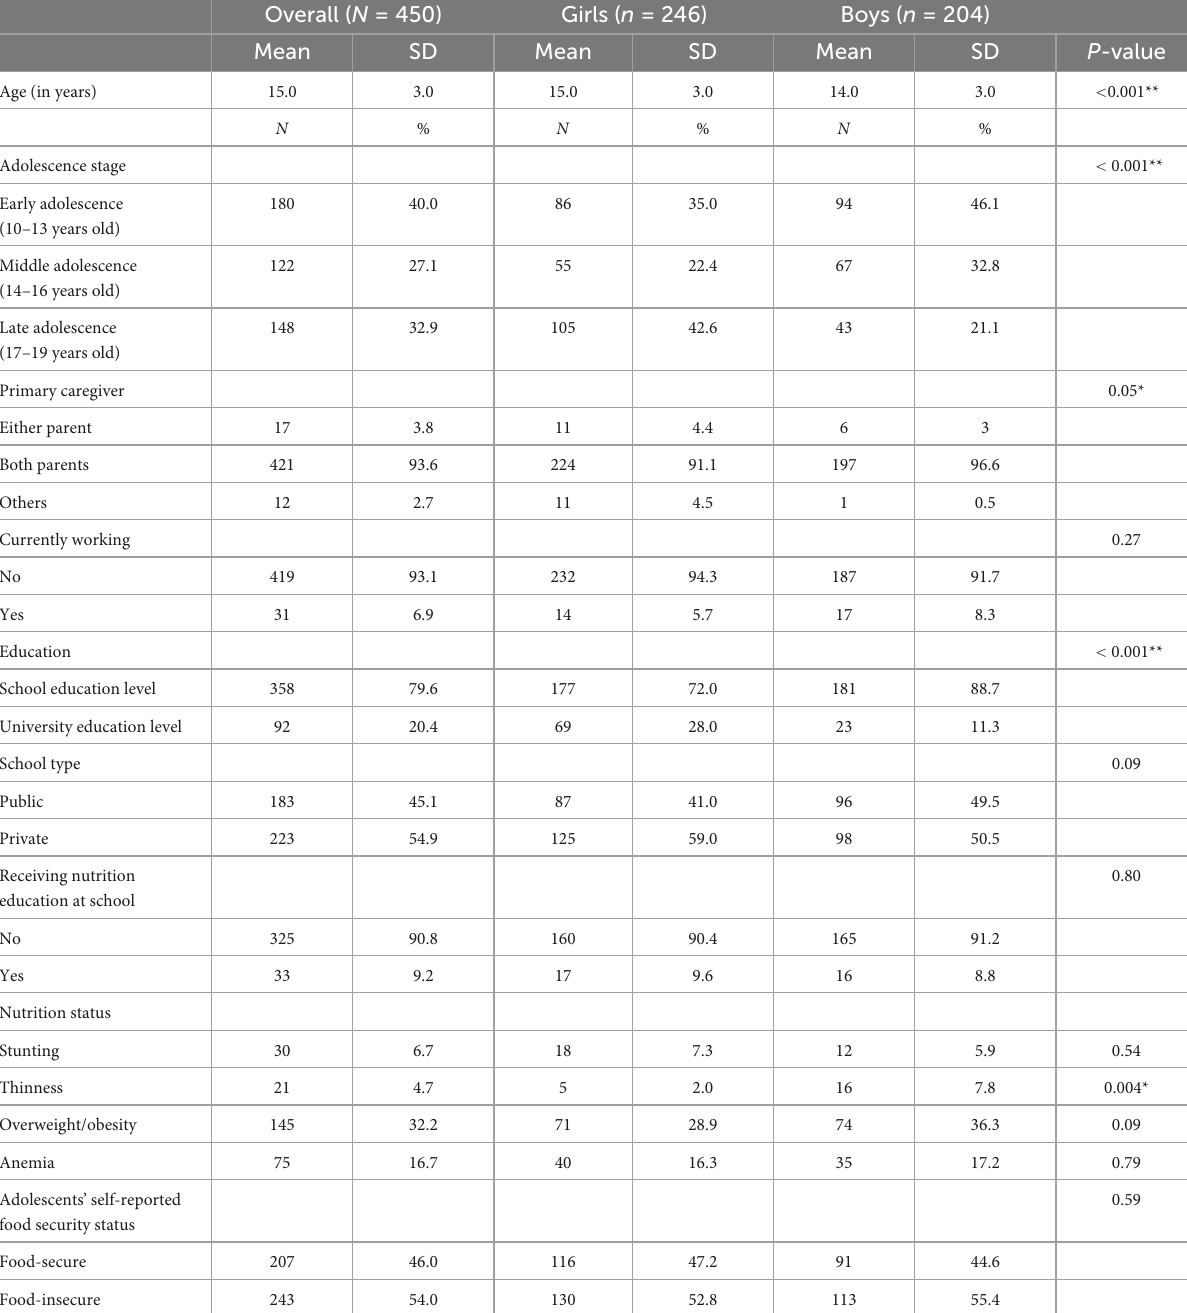
TABLE 2 Adolescents’ demographic characteristics and nutrition status, and the self-reported adolescent food security